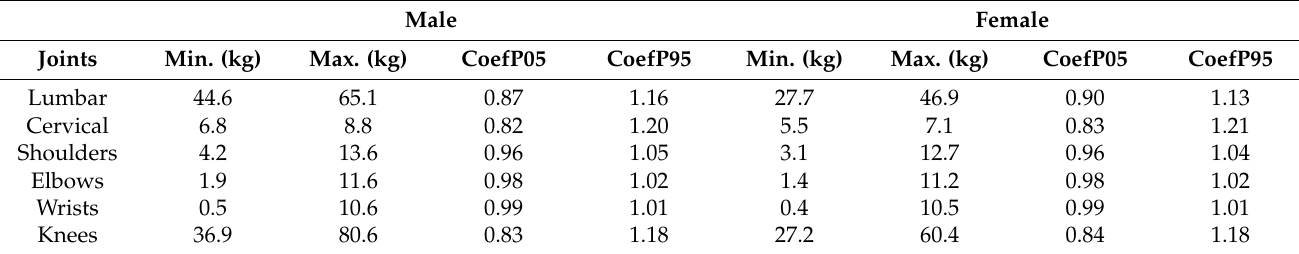
Table 8. Maximum and minimum torque for the 50th percentile; coefficients for 5th and 95th percentiles. Male Female Min. Joints